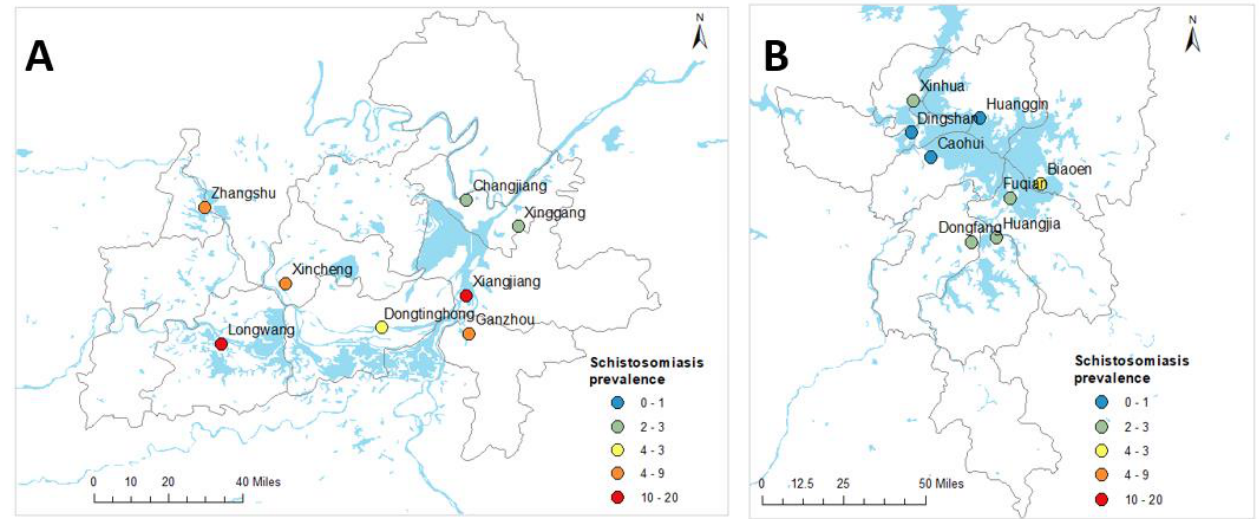
Figure 1. Geographical locations of village centroids and observed prevalence of schistosomiasis in Hunan ( A ) and Jiangxi ( B ) provinces, People’s Republic of China.